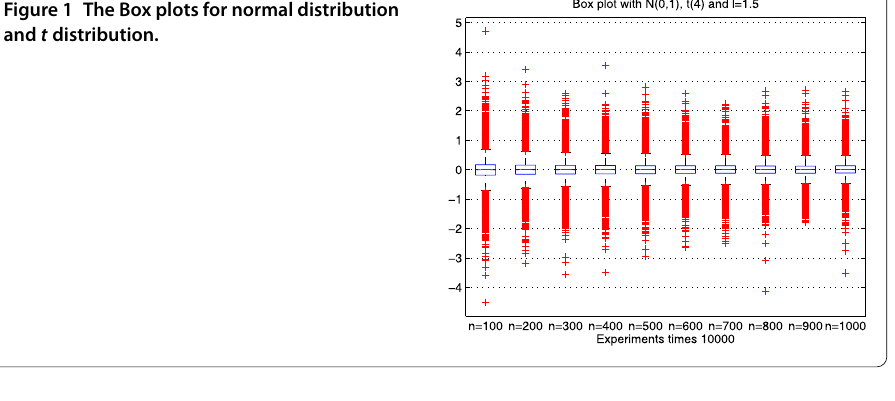
Figure 2 The Box plots for normal distribution and t